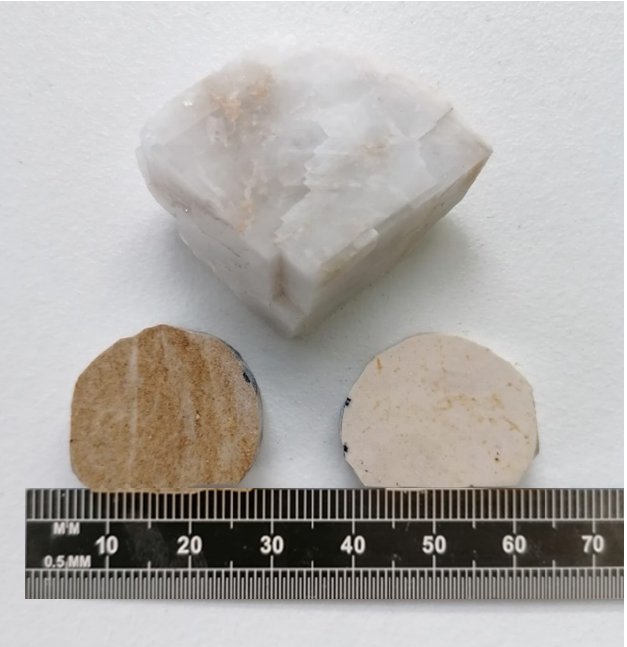
Figure 5. Cylindrical rock plugs of Ciply Chalk ( bottom left ) and Obourg Chalk ( bottom right ), and pure single calcite ( top ) used for surface characterization. The scale is given by the ruler in mm.